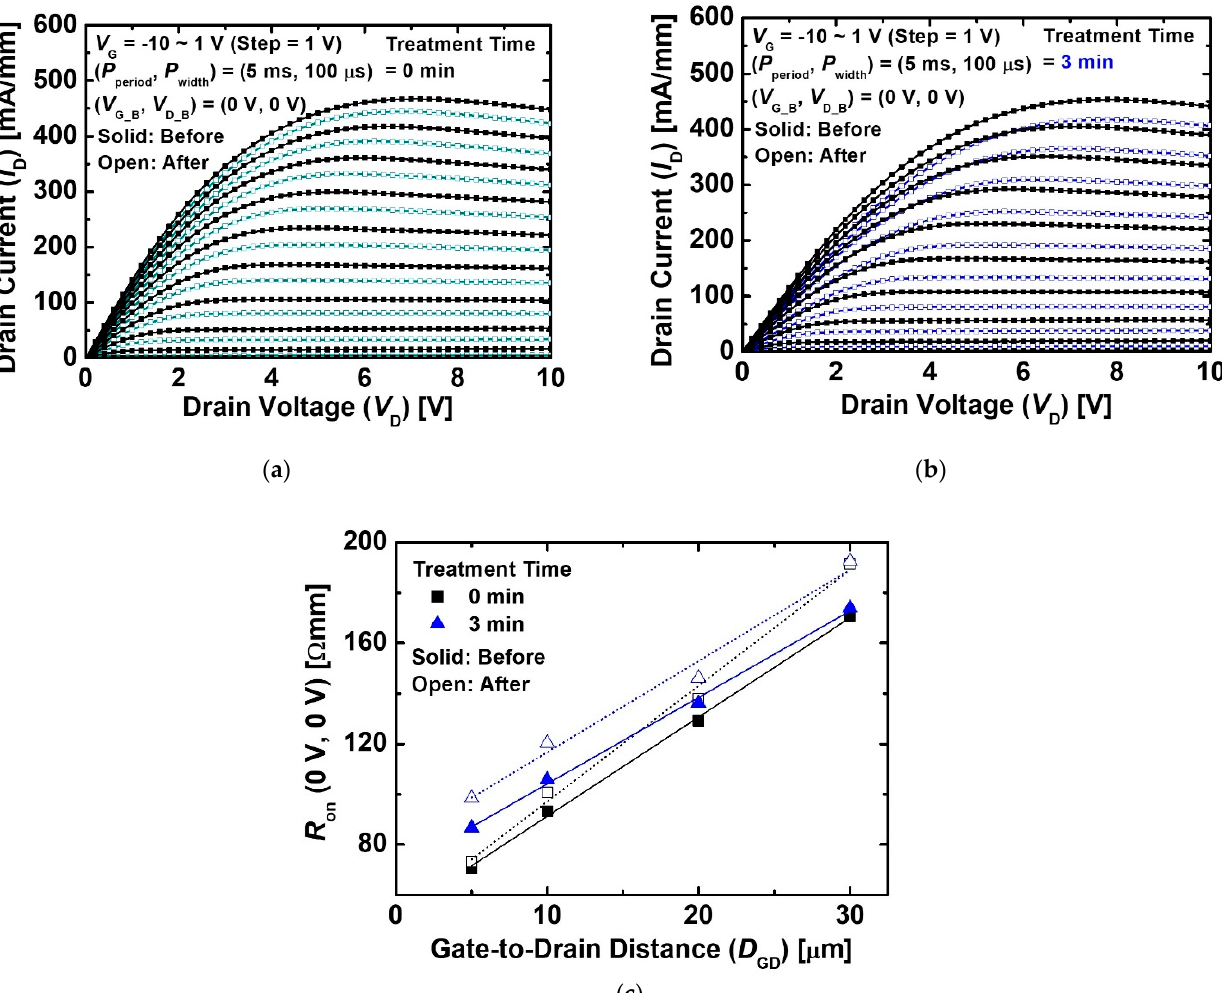
Figure 6. Pulse ‐ mode output I D ‐ V D characteristics of the MIS ‐ HEMTs ( a ) without treatment and ( b ) with treatment for 3 min before and after the proton irradiation. The L G , D GS , and D GD of the device was 3, 5, and 5 μ m, respectively. ( c ) Variation of R on as a function of D GD. The V G_B and V D_B were 0 V. The P period and P width were 5 ms and 100 μ s, respectively.